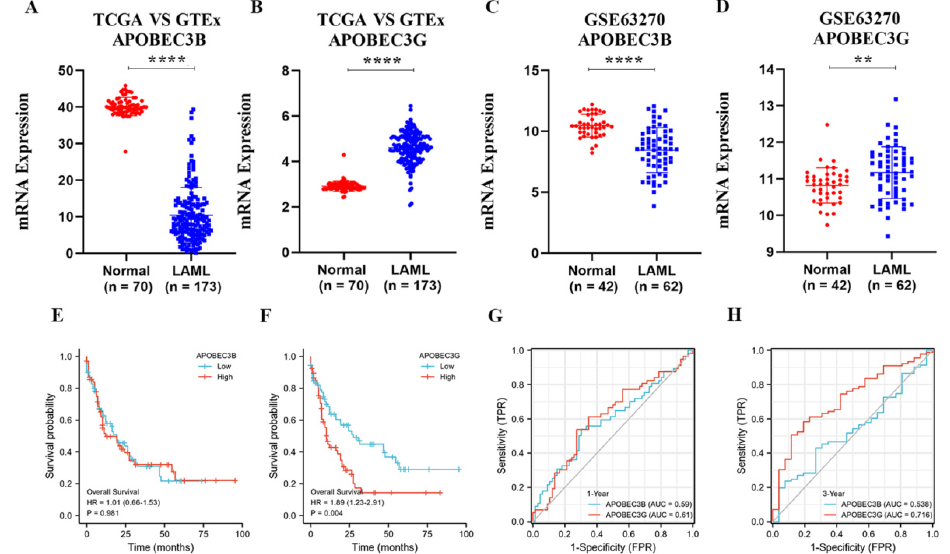
Figure 2. The expression of APOBEC3B/G and the correlations with overall survival of AML: ( A , B ) Dot plot show the expression profiles of APOBEC3B/G of the AML patients in the TCGA-LAML cohort ( n = 173) compared to normal control ( n = 70) from GTEx; **** p < 0.0001 vs. normal group. ( C , D ) Dot plot show the expression profiles of APOBEC3B/G of AML patients (n = 42) compared to normal control (n = 62) in GSE63270 cohort; **** p < 0.0001, ** p < 0.01 vs. normal group. ( E , F ) Prognosis analysis on OS (Overall Survival) was conducted based on the expression of APOBEC3B/G and survival status in the TCGA-LAML cohort (n = 140 after case-wise deletion) by R studio. Patients were dichotomized into a high- and a low-expression group, with the median mRNA expression level as the cutoff value, p value, and HRs (Hazard Ratio) were computed by log-rank test and Cox regression to draw the KM (Kaplan – Meier) curves; ( G , H ) The predictive accuracy of APOBEC3B/G were evaluated by time-dependent ROC (receiver operating characteristic) analysis at 1 or 3 years. AUC (area under the curve) values present the prediction ability.